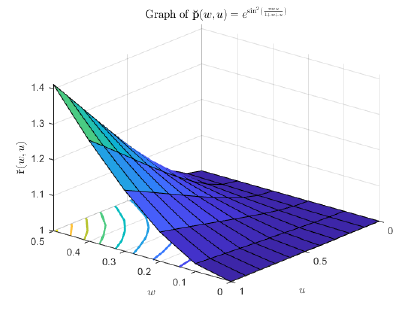
Figure 2. The graph of ˘r ( w , u ) in Example